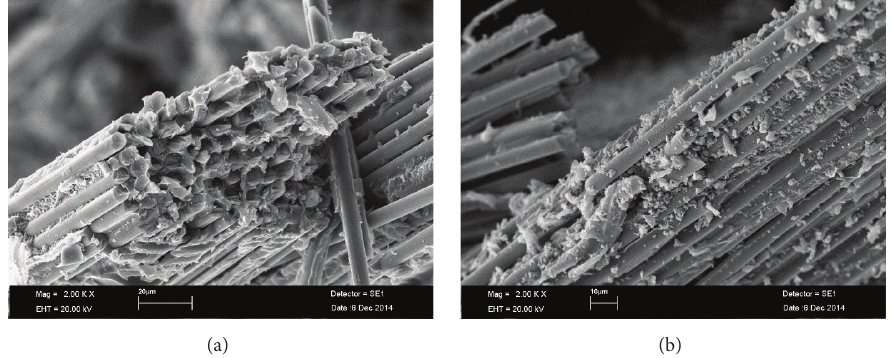
Figure 12: SEM image of VARTM specimen (a) and Vacuum Bagging specimen (b).